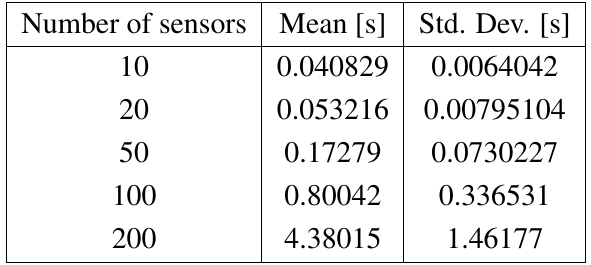
Table 2. Computation times for networks of different sizes. Results obtained with Mosek 5 (64-bit version) with a Core 2 Duo CPU at 3.16 GHz and with 4 GB RAM.